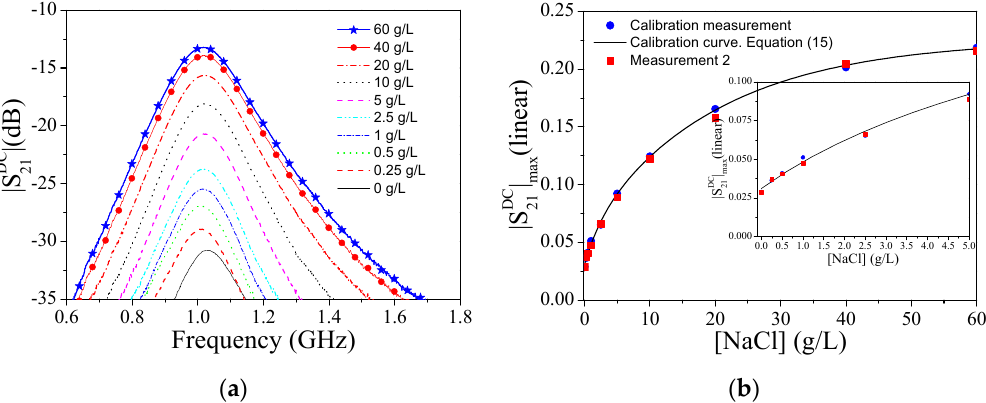
Figure 8. ( a ) Cross-mode insertion loss for different concentrations of NaCl ( b ) Variation of |S 21DC | max with NaCl content.